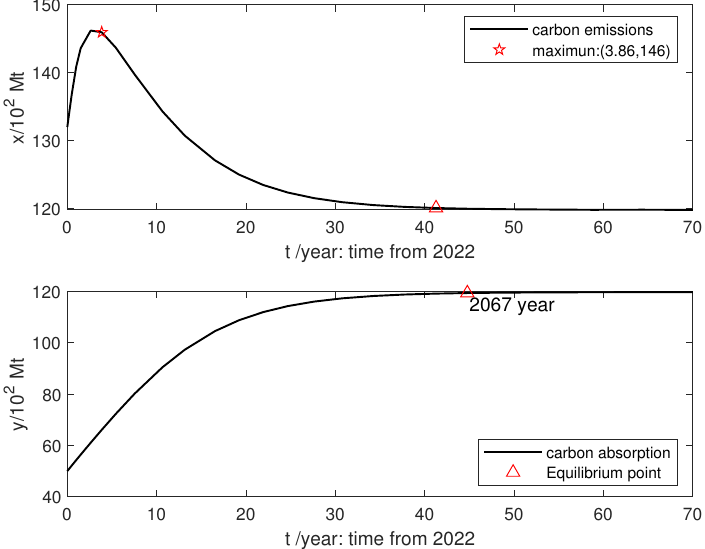
Figure 6. When τ = 0.5, the system (3) is locally asymptotically stable at the equilibrium point E 3 . ( 0 ) = 3.606, from Theorem 4, we learn that the system (3) has a When τ = 3.61 > τ 1 stable periodic solution at the at the equilibrium E 3 , as shown in Figure 7.